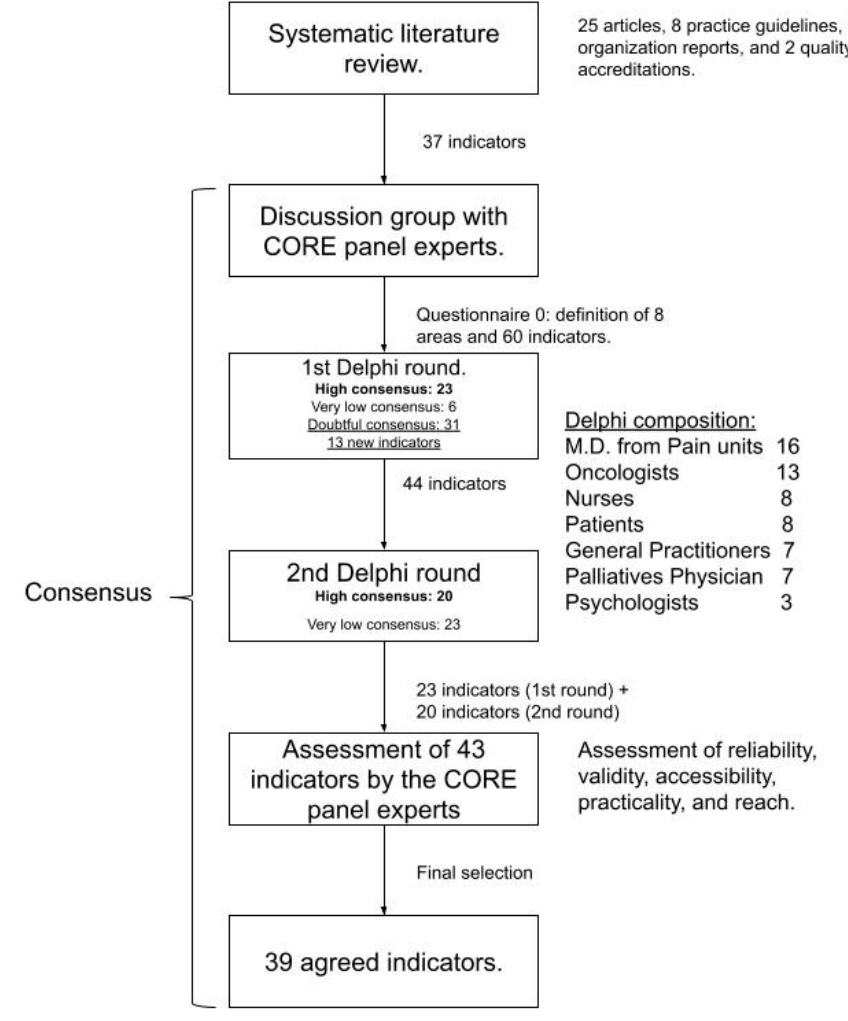
Figure 2. Flowchart of the Delphi process. Table 1. ACDON accreditation